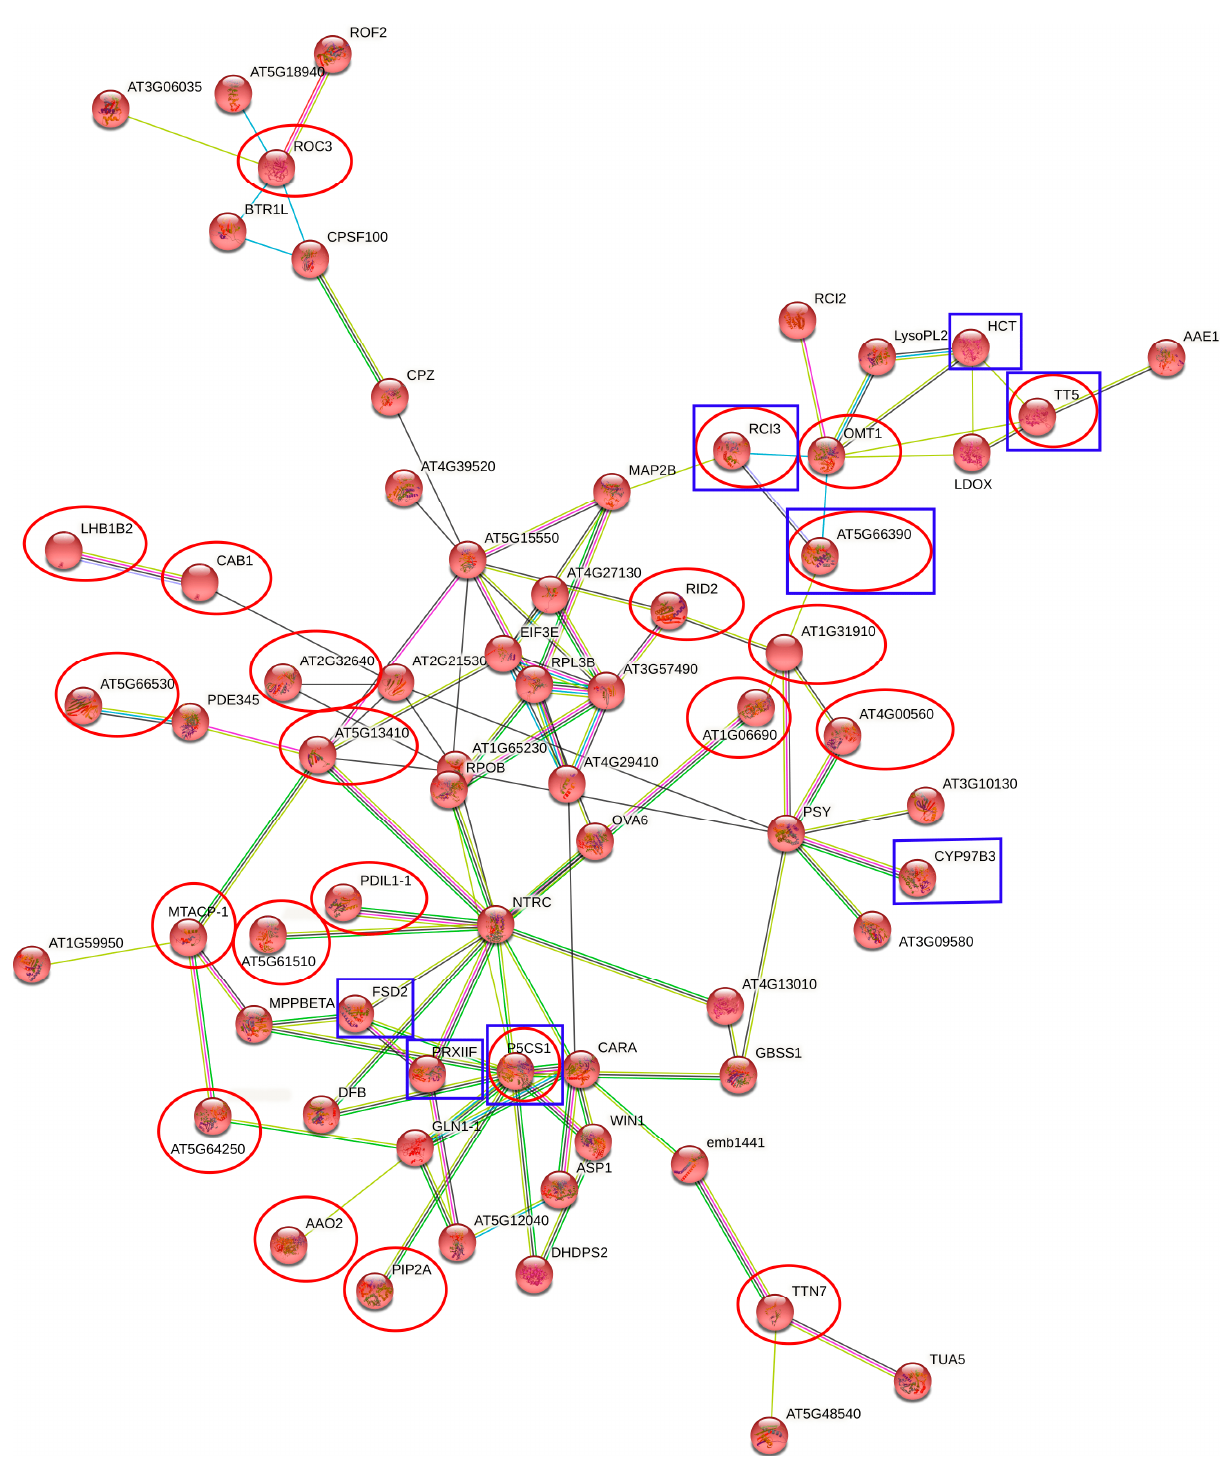
Figure 3. Co-expression network of drought-tolerance-related DEPs. The empty nodes represent proteins of an unknown 3D structure, and the filled nodes signify that some 3D structure is known or predicted. Edges represent protein–protein associations (bright blue and pink—known interactions, green and dark blue—predicted interactions, yellow—text mining, black—co-expression, multicolor—protein homology). Proteins marked in the red circle were those with an adjusted p -value < 0.05. Proteins marked in the blue square are associated with drought stress. Disconnected nodes or proteins not connected to the main network were hidden in the network.